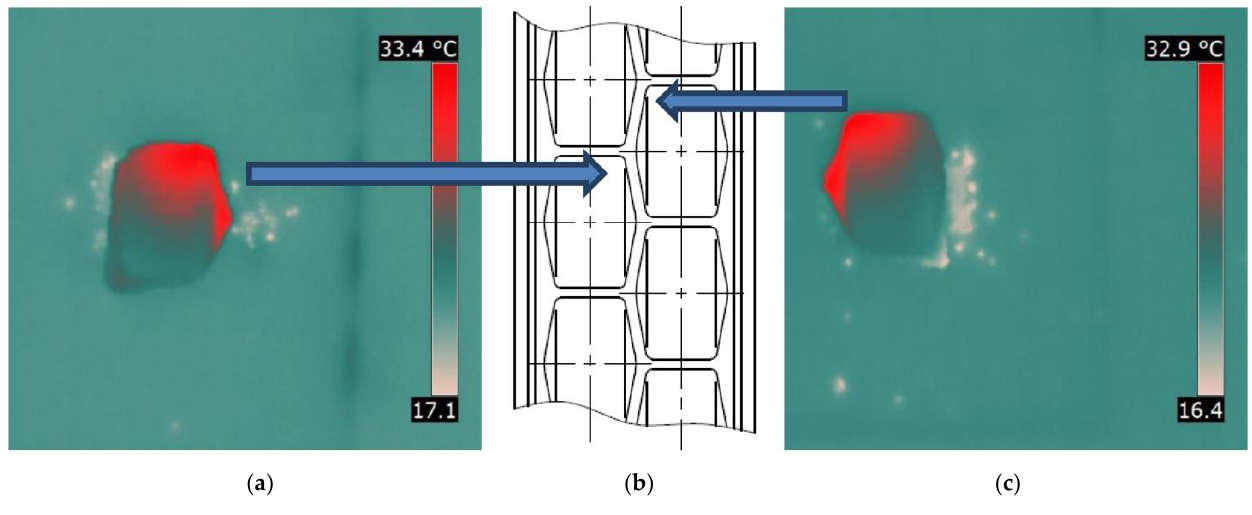
Figure 13. Comparison of thermograms of briquettes obtained from the M2 mixture (mill scale) taken from two different rows of forming cavities: ( a ) left row briquette, ( b ) scheme of working surface, and ( c ) right row briquette.